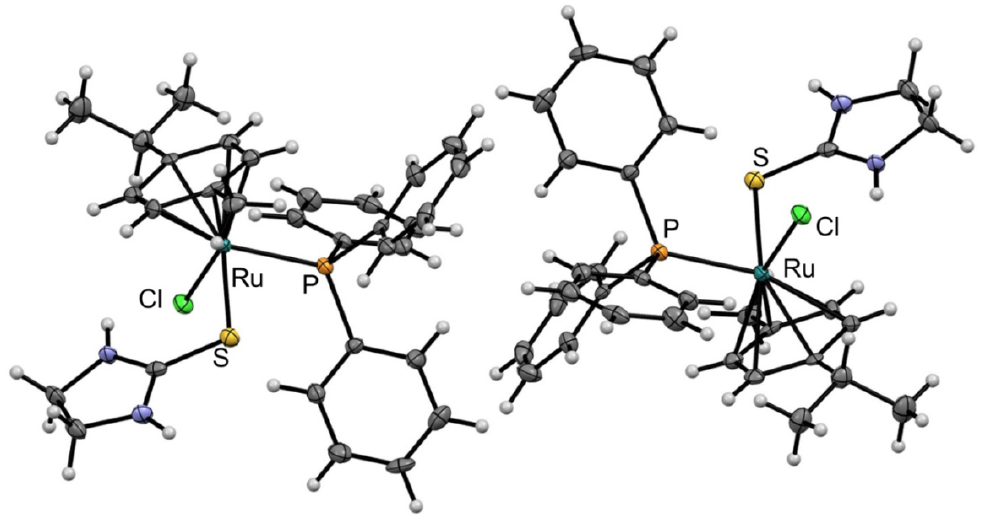
− counter anions are not shown. Cl and PF 2 2 6